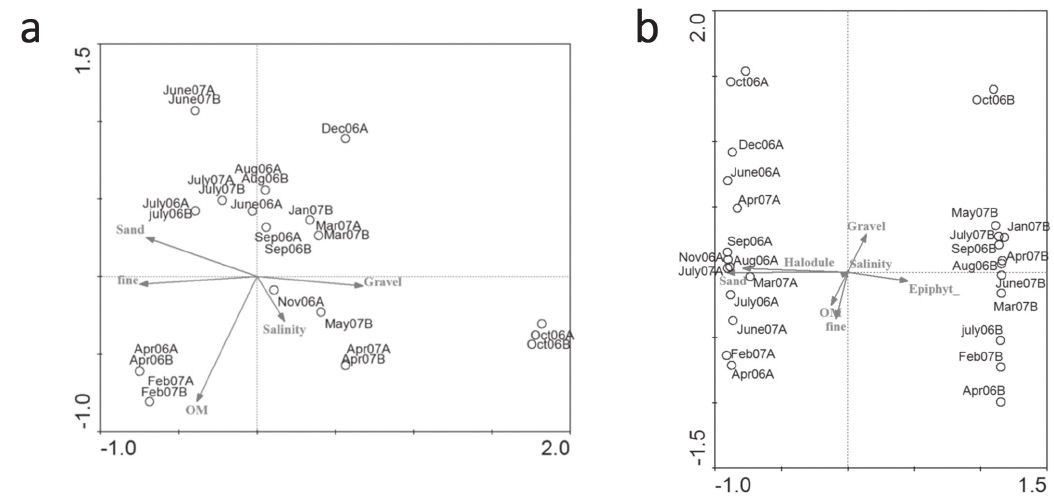
Figure 4 - Canonical Correlation Analysis (CCA) diagrams and samples (months) dispersion of the abundance of molluscan (a) and descriptors of community (b) . Legend of Vectors: Gravel – Percentage of Gravel percentage; Salinity - Salinity; Epiphyt_ – Hypnea muscioformis biomass; Fine – Percentage of Fine; OM – Organic matter content; Sand – Percentage of Sand; Halodule – Halodule wrightii biomass. Legend of samples: A – Belowground; B –